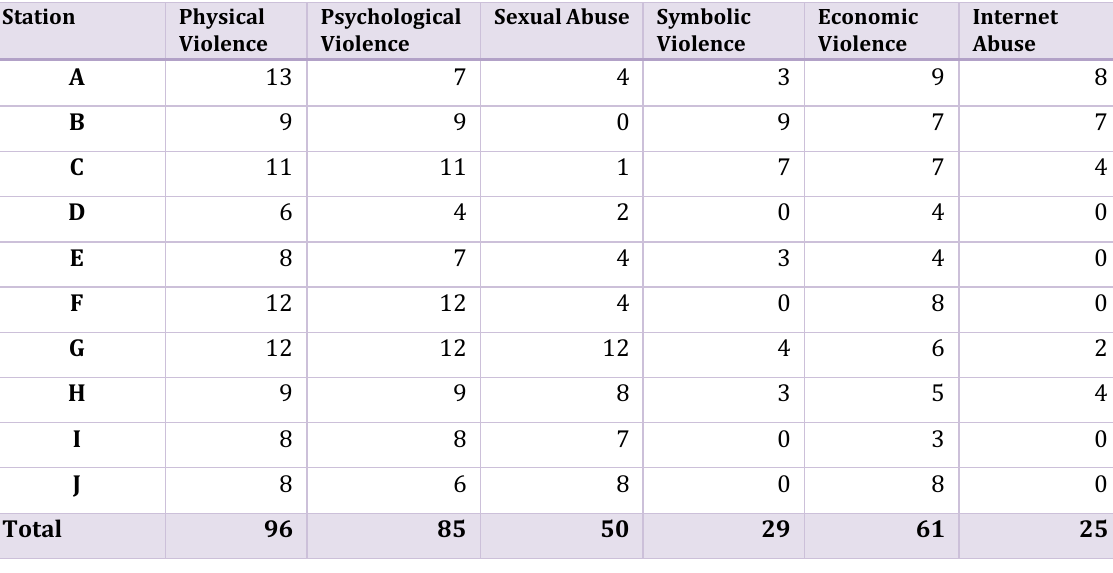
Table 6: What types of violence are reported most